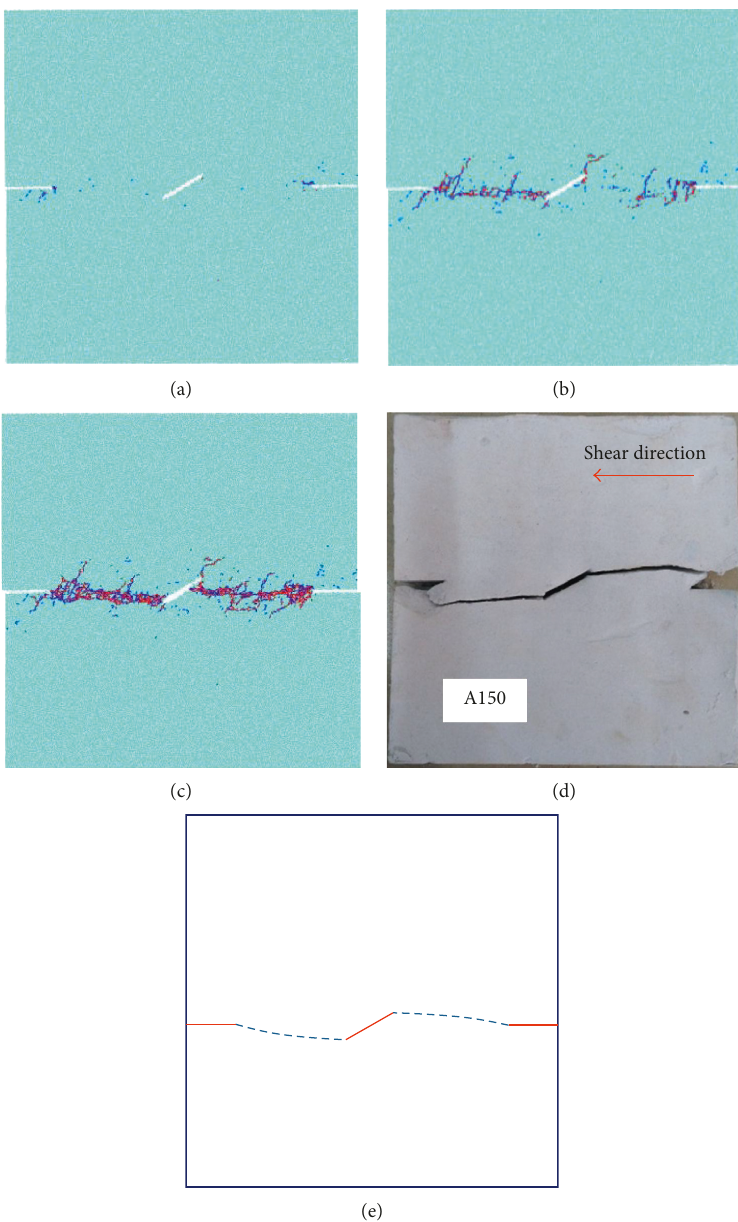
Figure 12: Fracturing process of Sample A150. (a) Point A. (b) Point B. (c) Point C. (d) Real failure. (e) Single